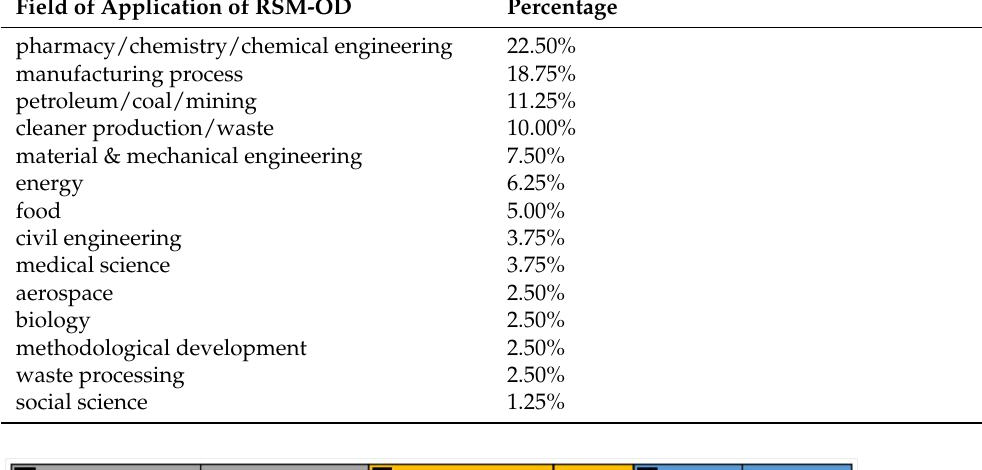
Table 2. Distribution of papers based on research fields.